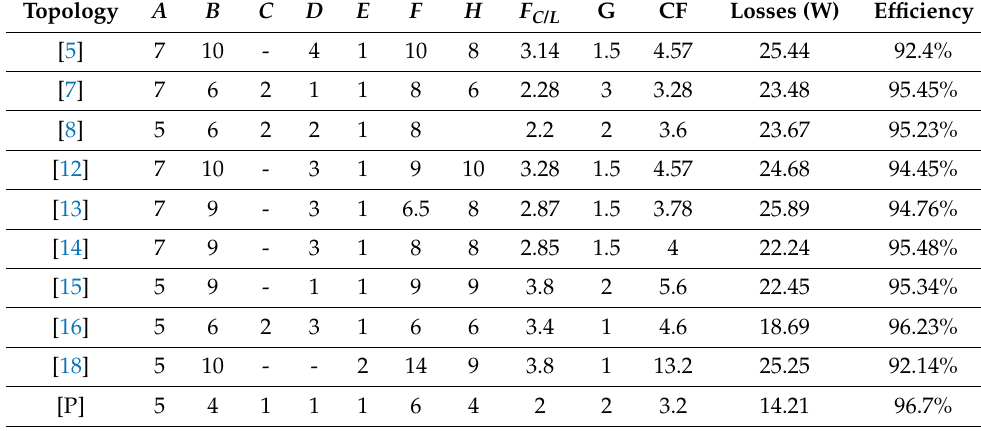
Table 2. Comparative assessment for per phase leg with recent SCMLI topologies.